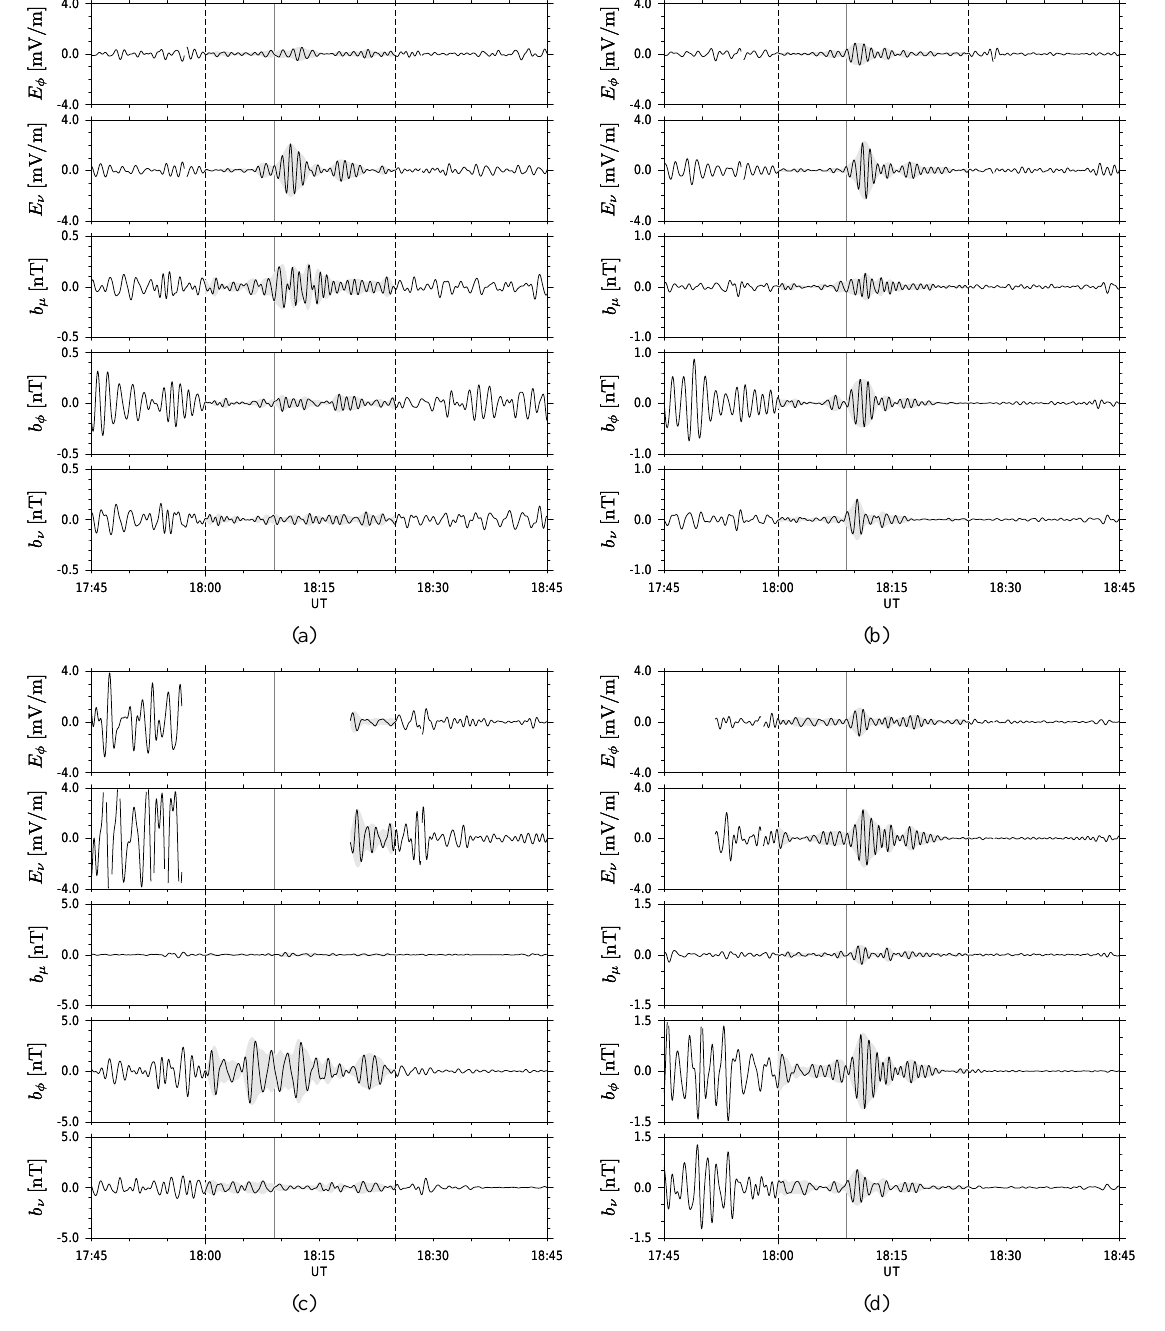
Fig. 4: EFW and FGM waveforms for 21 January 2003 on (a) C1 [Rumba], (b) C2 [Salsa], (c) C3 [Samba] and (d) C4 [Tango]. The signals have been bandpass filtered to extract periods in the range 40– 150 s . The gaps in the EFW data for C3 and C4 occur where it was not feasible to apply E · B = 0 , and transformation of the electric field to MFA coordinates was thus impossible.